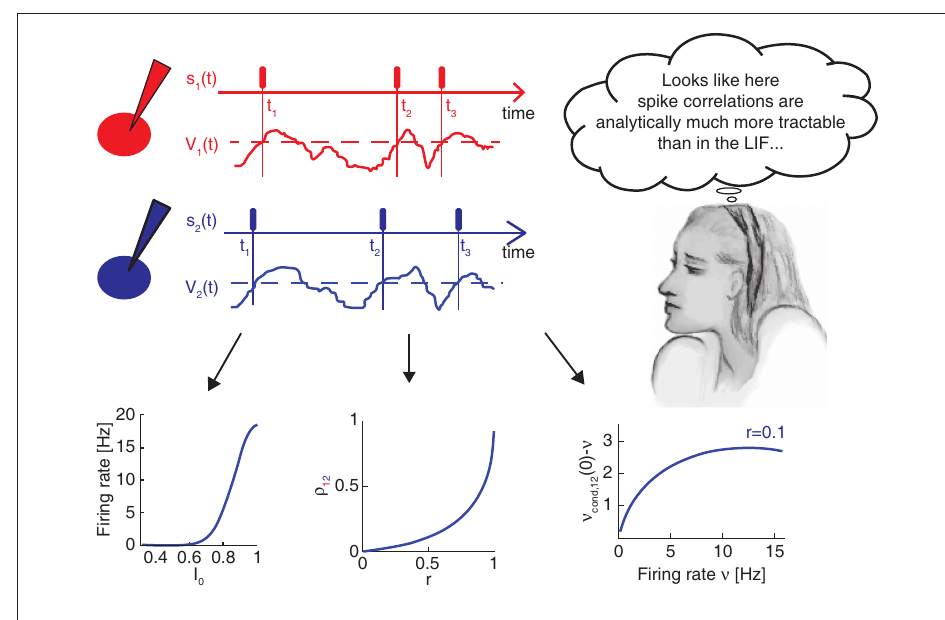
incorporated as symmetric voltage cross correlations. Tractable analytical results can be obtained for the dependence of firing rate on the mean driving current I ( t ) and s ( t ) 1 2 (bottom left), correlation coefficient r correlation strength r (bottom center) and the weak pairwise spike correlation ν ( t ) 1 firing rate n (bottom